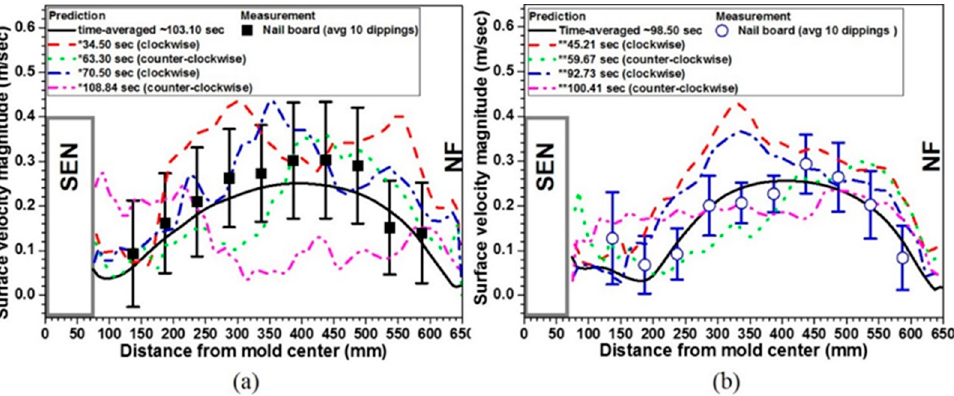
Figure 15. Surface velocity variations comparing LES modeling and measurements ( a ) without and ( b ) with double-ruler EMBr [113]. Metals 2018 , 8 , x FOR PEER REVIEW